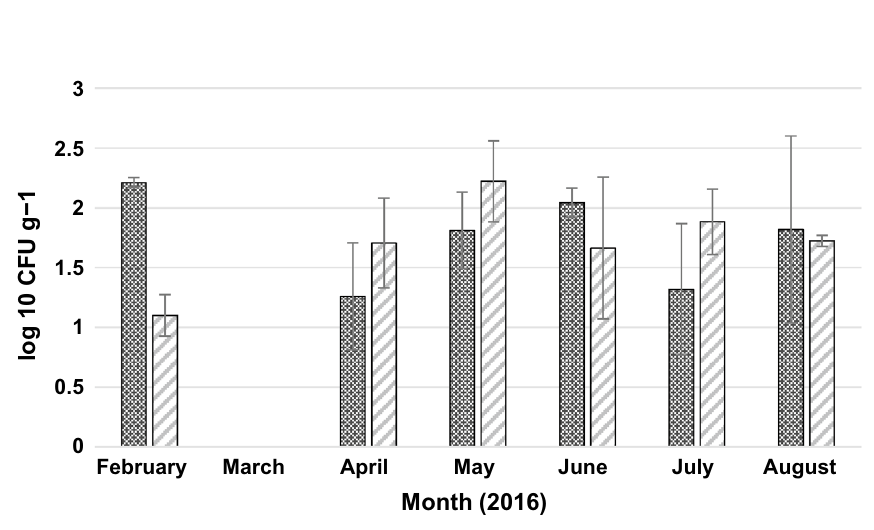
Fig. 12 Monthly variation of E. coli in turfgrass sampled in